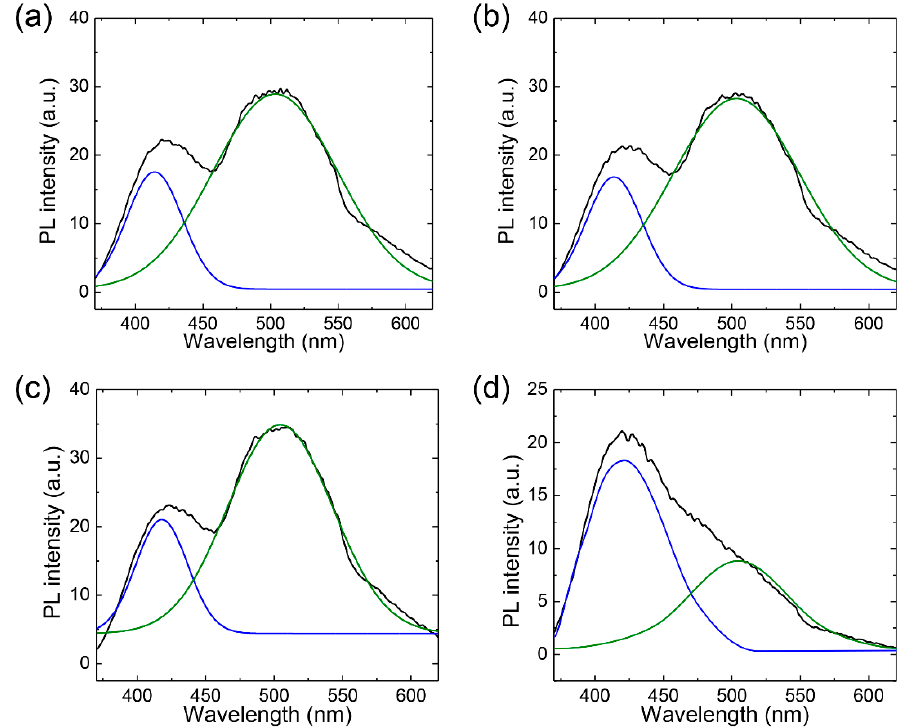
Figure 7. Peak deconvolution in photoluminescence spectra excited at 368 nm. ( a , b ) PL spectra from (a) feed and (b) permeate solutions in dead-end filtration. ( c , d ) PL spectra from (c) feed and (d) permeate solutions in cross-flow filtration.